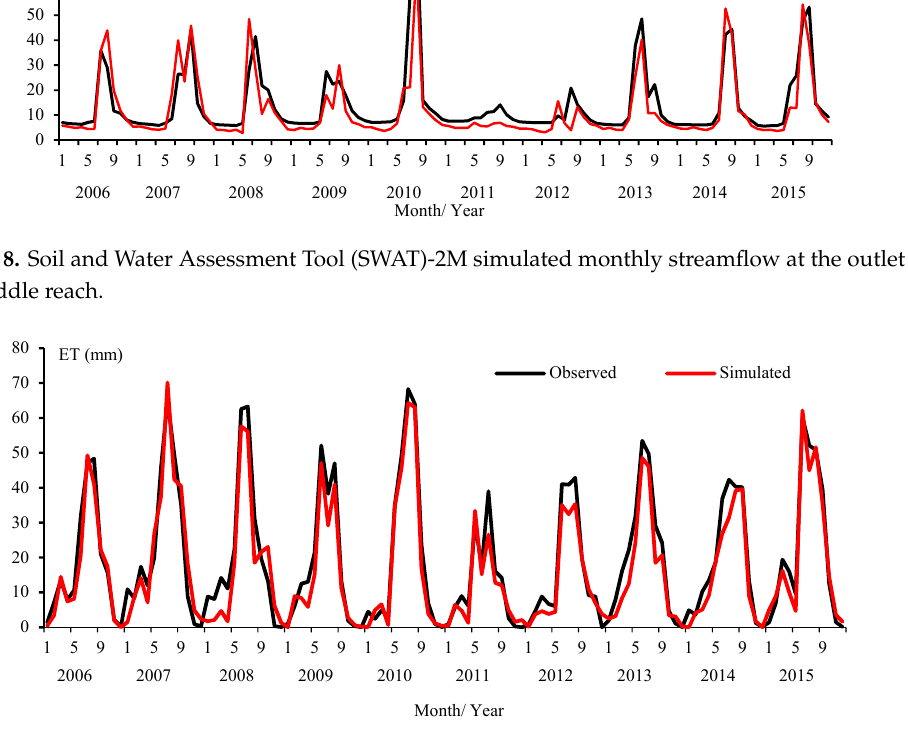
Figure 9. Soil and Water Assessment Tool (SWAT)-2 simulated monthly evapotranspiration (ET).